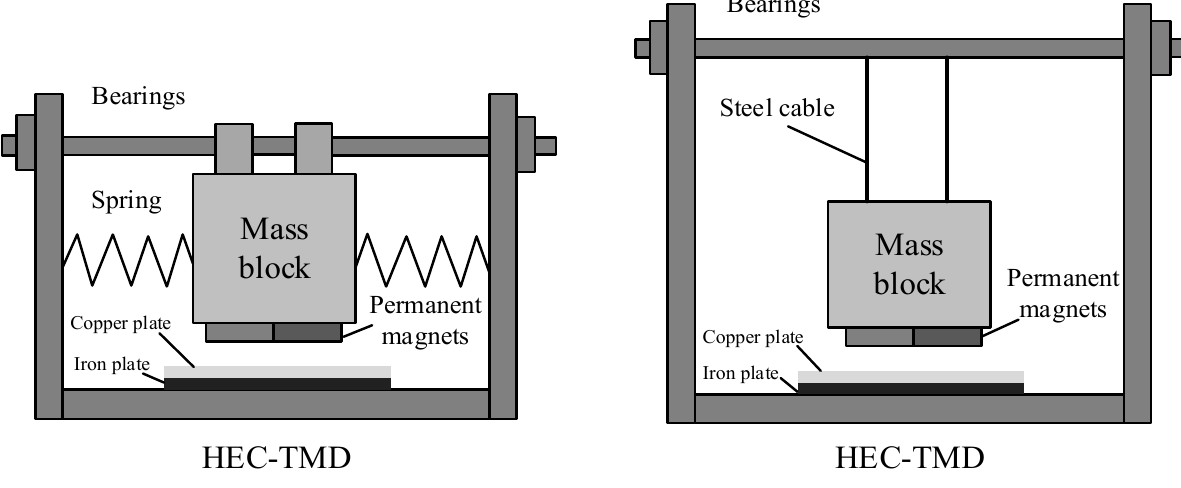
Figure 4. Schematic diagram of two types of EC-TMD structures [36].